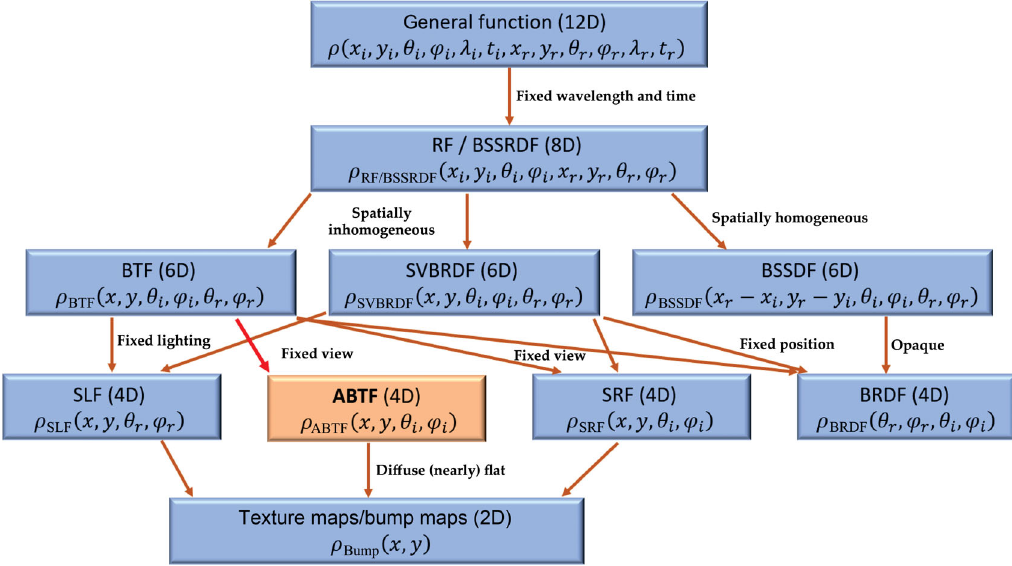
Fig. 1 ABTF model in the surface reflectance function taxonomy introduced in Ref. [4], derived from BTFs and depending on the same variables as surface reflectance functions (SRF), but with different